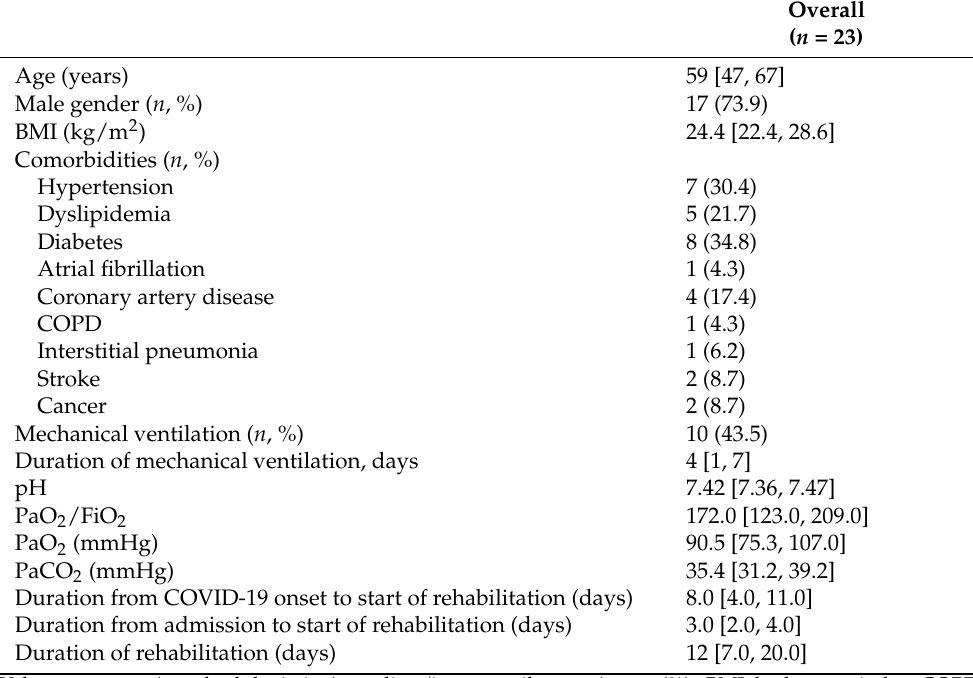
Table 1. Baseline patient